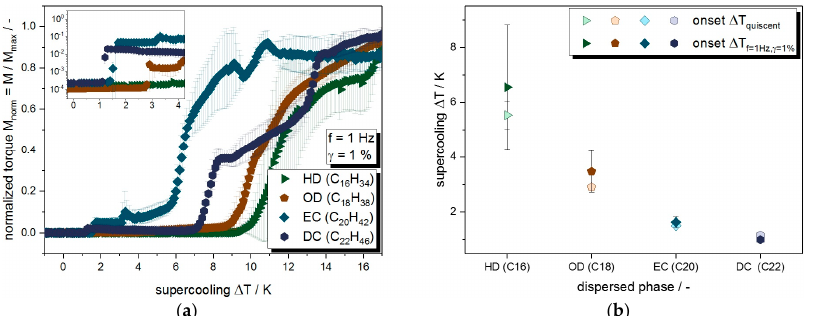
Figure 4. ( a ) Normalized torque M norm of 10 wt % alkane dispersions under low oscillation mechanical stress as a function of supercooling ∆ T ; ( b ) Comparison of onset crystallization supercooling during quiescent crystallization onset ∆ T quiscent and crystallization under low mechanical stress onset ∆ T f = 1 Hz , γ = 1%